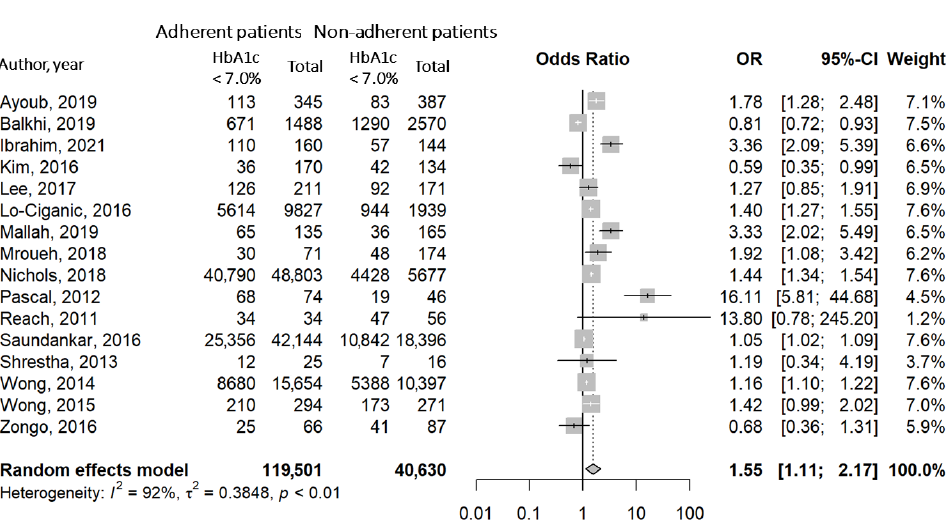
Figure 4. Forest plot with OR and relative confidence intervals for the association between good adherence and good glycemic control (HbA1c < 7.0%). White lines: confidence interval within the square. Black lines: confidence interval crossing the bounds of the square [40,41,88,98,102,105,109,116,120,131,140,149,152,174,173,180].